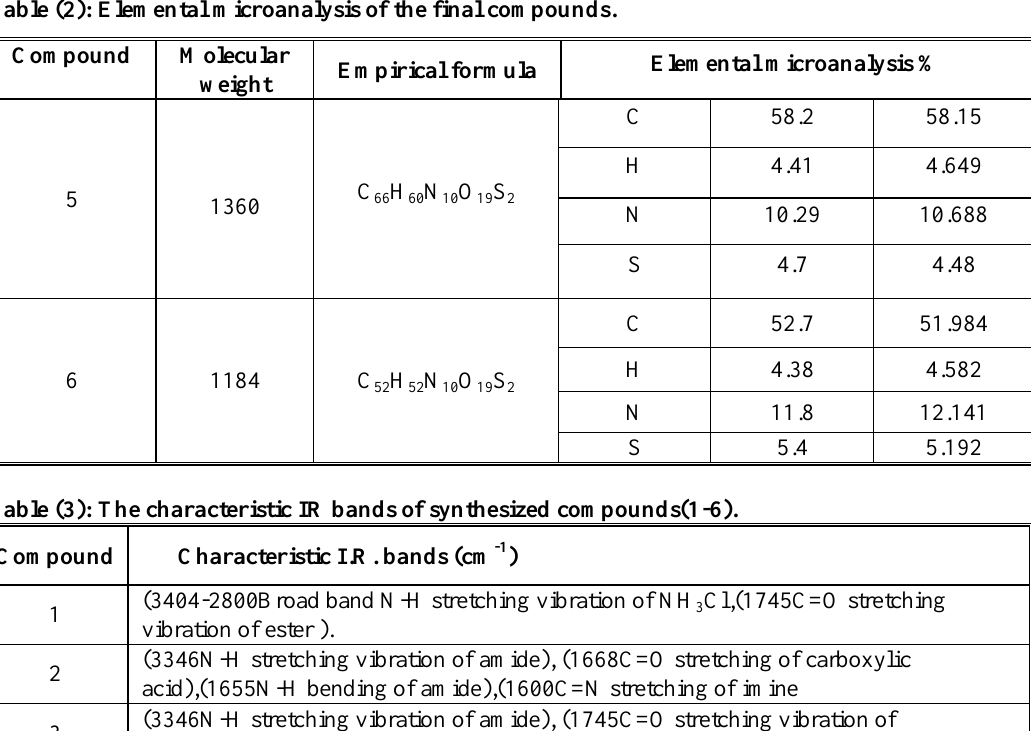
Table (2): Elemental microanalysis of the final compounds.